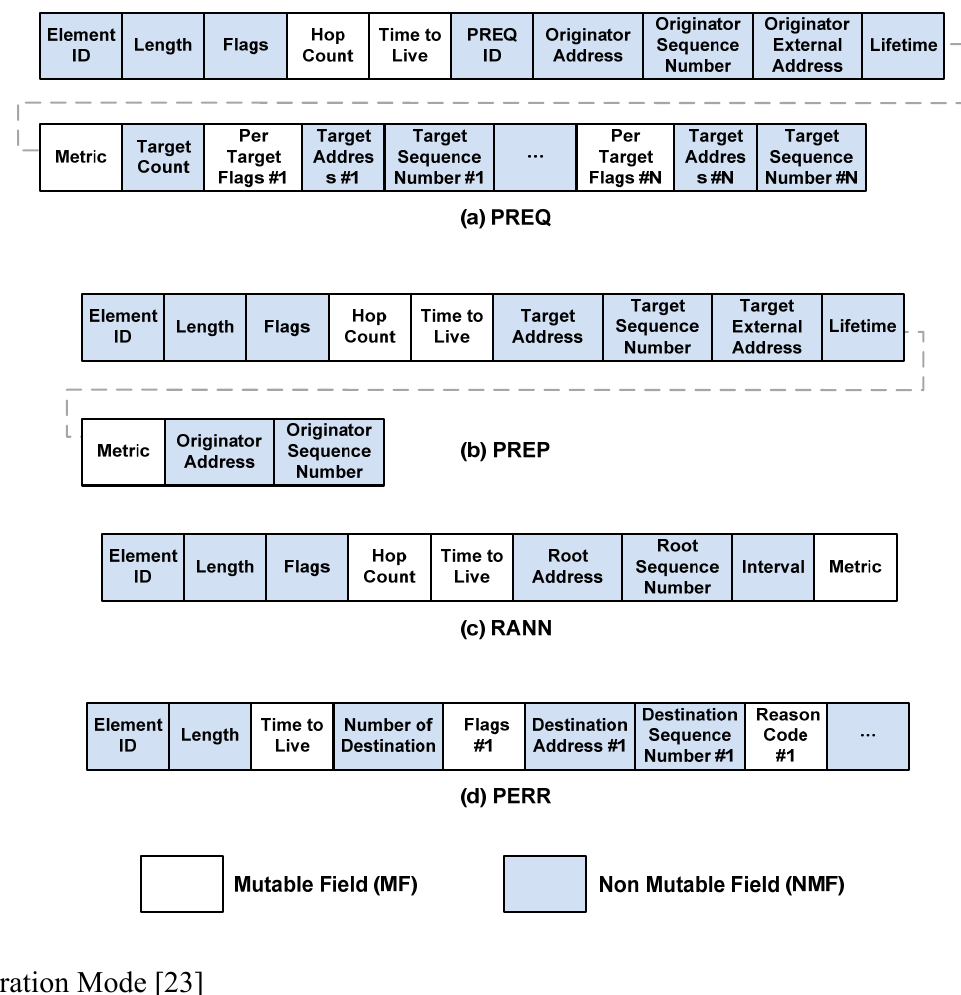
Figure 5. MF and NMF of PREQ, PREP, RANN, and